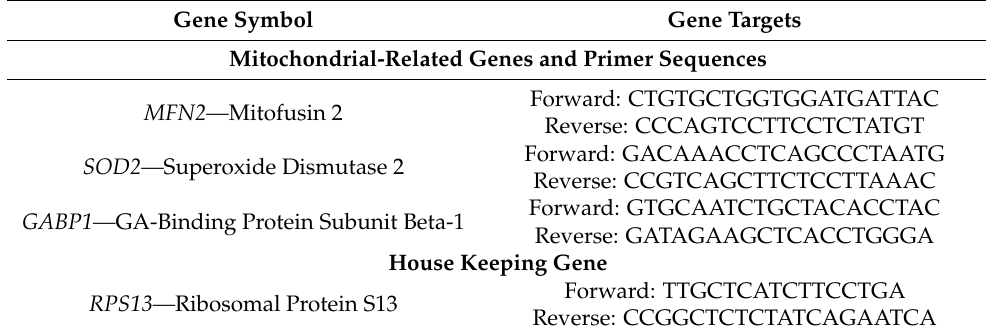
Table 1. List of gene targets analyzed by